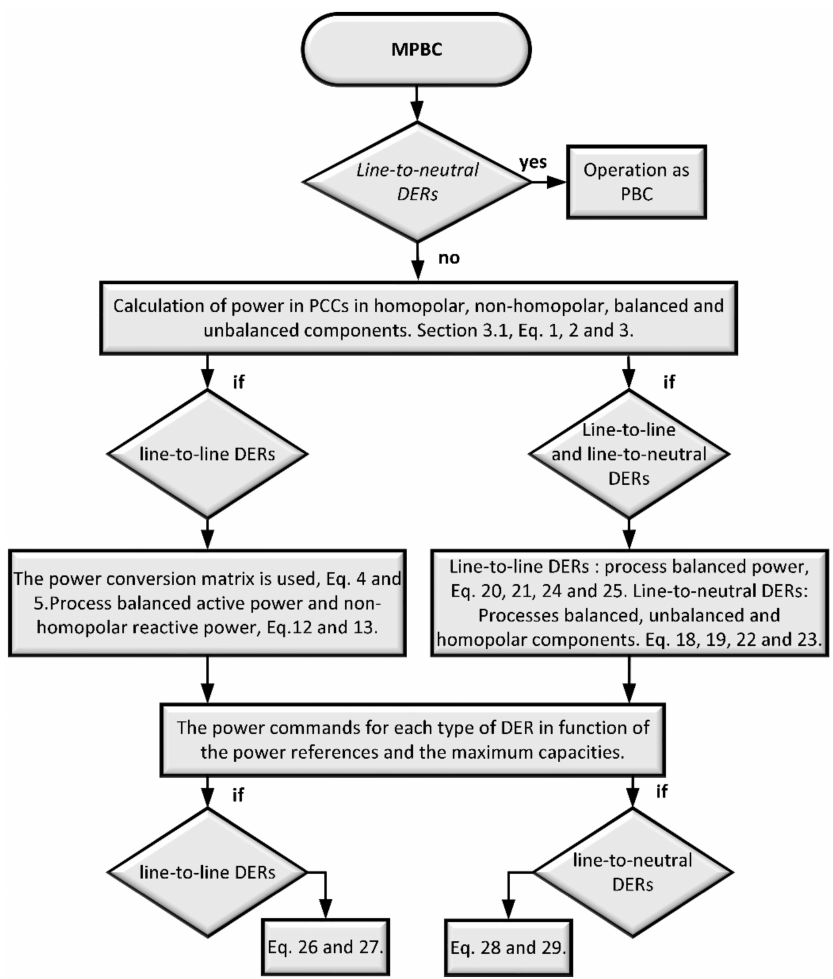
Figure 3. MPBC execution